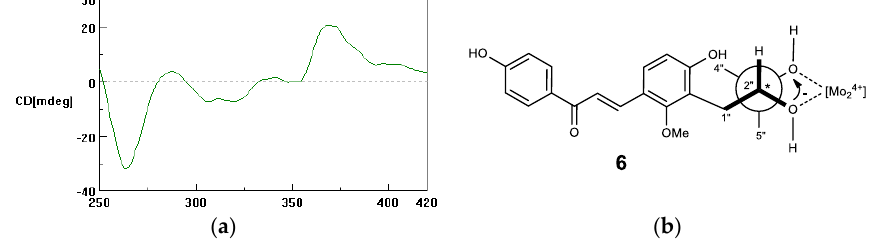
Figure 1. ( a ) ICD spectrum of the Mo-complex of 6 ; ( b ) Determination of the absolute configuration at C-2’’ of 6 by the application of Snatzke’s method. C-2” of 6 by the application of Snatzke’s